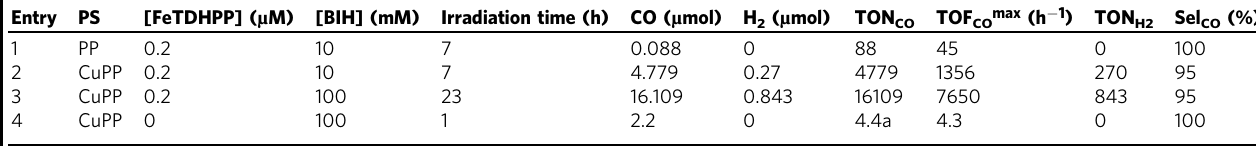
a Calculated by the equation TONCO = n (CO)/ n (CuPP). Comparison data for the photocatalytic systems in CO 2 -saturated DMF solution.